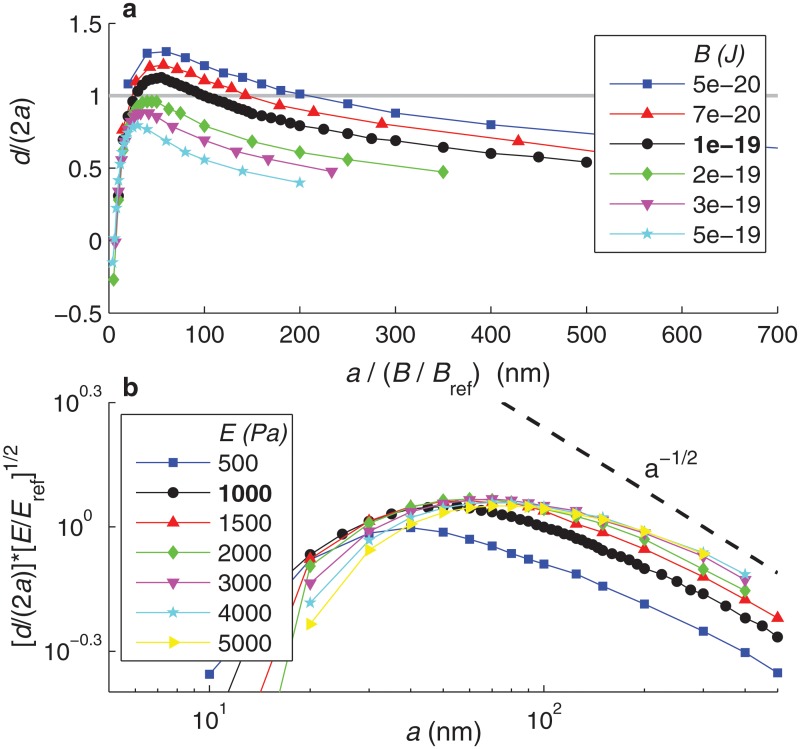
Analysis of the dependence of the maximum internalization depth on physical parameters B, E, and a.
a. Dependence of the maximum internalization depth, d/(2a), on the membrane bending modulus B. This plot presents the results of Fig 7a, here with the horizontal axis transformed into a/(B/B
ref), with B
ref ≡ 10−19 J. b. Dependence of the maximum internalization depth, d/(2a), on the cell’s Young modulus E. This plot presents the results of Fig 7c, here with the vertical axis scaled as (d/(2a))(E/E
ref)1/2, with E
ref ≡ 1000 Pa, and the figure presented in double logarithmic scale. The dashed line indicates the slope of the power law d/(2a) ∼ a
−1/2.